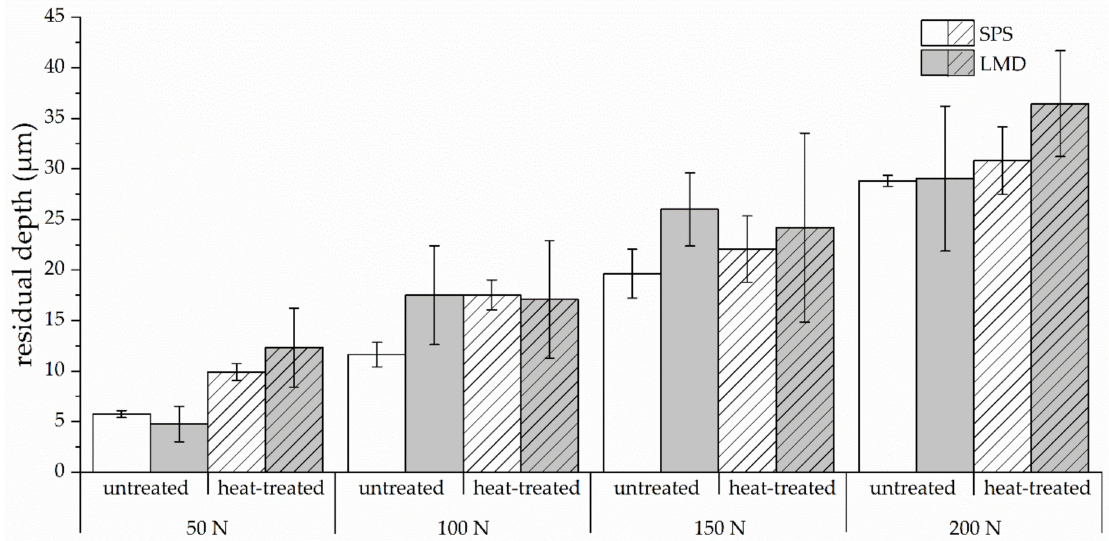
Figure 11. Constant load scratch testing of the untreated and heat-treated SPS bulk material and LMD coating of Al 0.3 CoCrFeNiNb 0.5 . Under various constant loads, the untreated SPS bulk material exhibited high abrasive wear